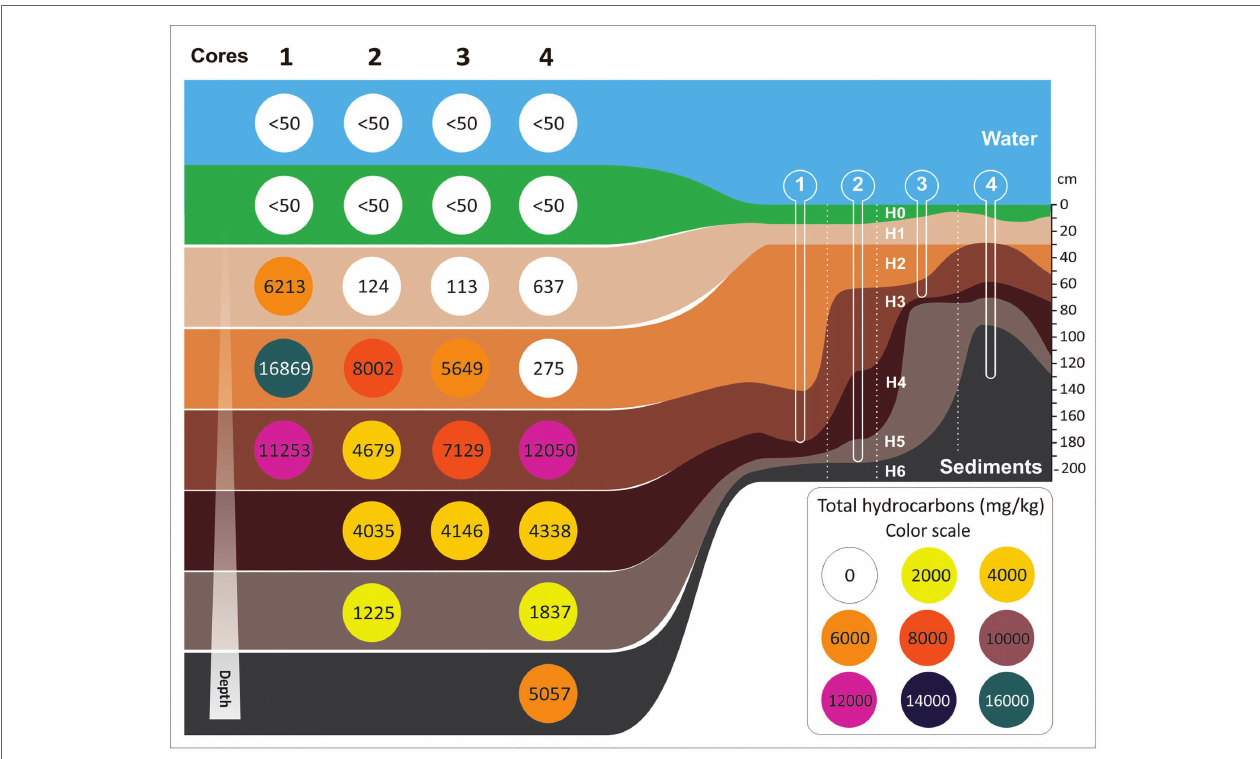
FIGURE 1 | Schematic representation of the horizons length (cm) and hydrocarbon concentration (mg/kg) on each core along the freshwater channel of this